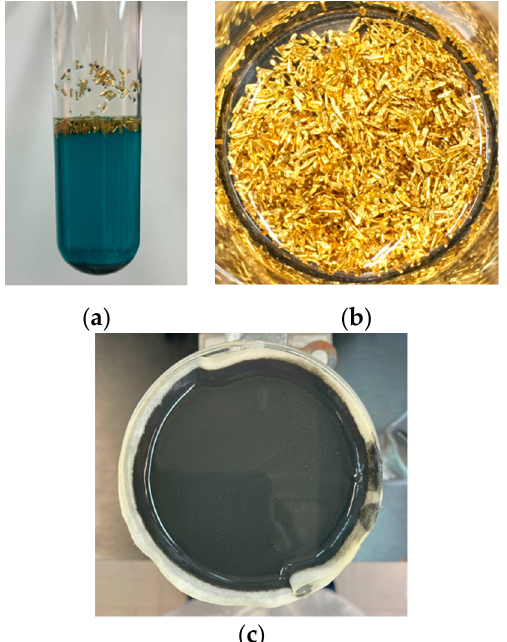
Figure 3. ( a ) Reaction tube after acid digestion with HNO 3conc , ( b ) recovered gold coatings and ( c ) CuO filtration after complexing and precipitation reactions.